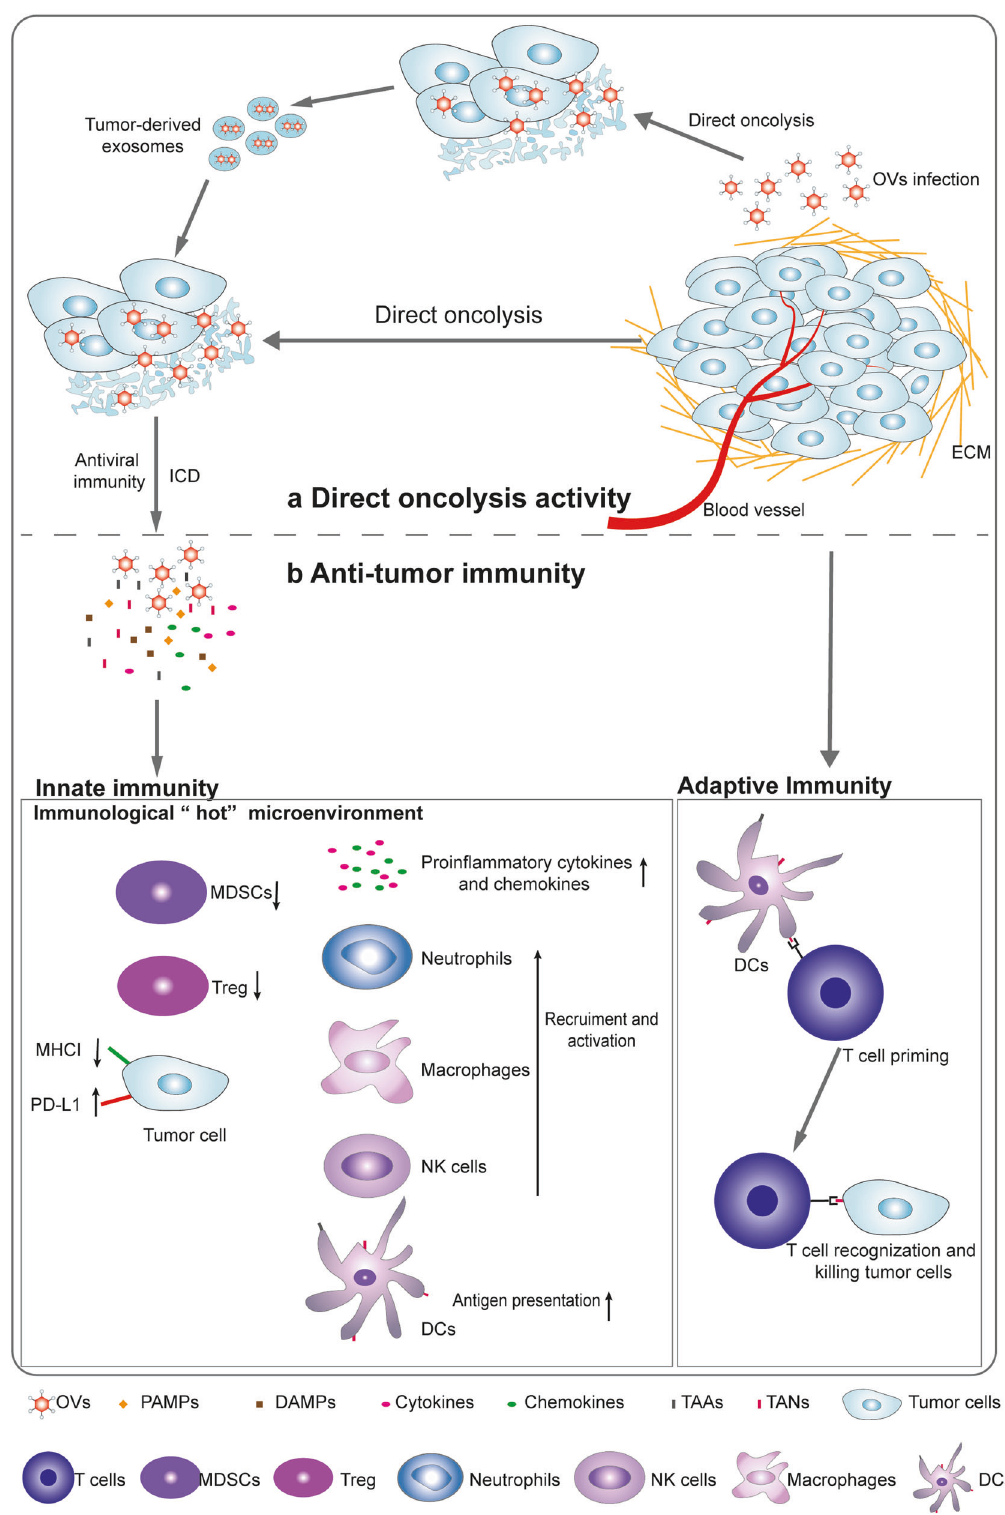
costimulation, and cytokines. OV-mediated oncolysis of tumor cells initiates the release of tumor-associated antigens and neoantigens (TAAs and TANs, respectively), which are processed by APCs to produce antigen epitopes ultimately presented on the APC surface in complex with MHC molecules. In the cytokine milieu produced after immune and tumor cell exposure to